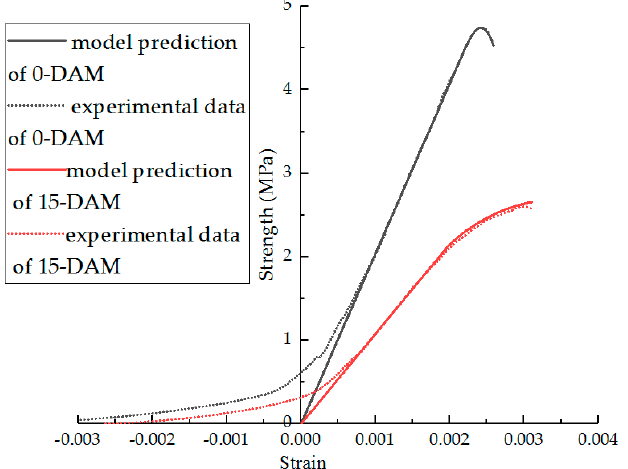
Figure 21. Comparison of experimental data and model predictions for DAM under F–T cycles.